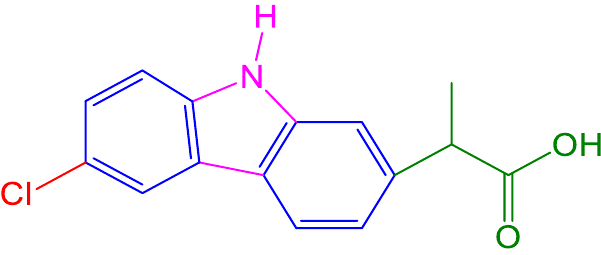
Figure 5. Structure of carprofen with anti-inflammatory activities.